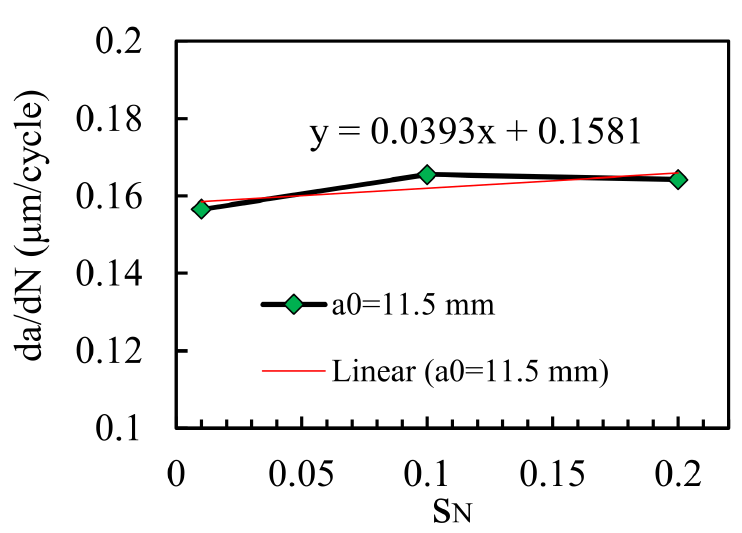
Figure 18. Effect of s N on da/dN . Results are presented in natural scales for three distinct values of s N : 0.01, 0.1, and 0.2. Coalescence is disabled , q 1 = 1.5, q 2 = 1, q 3 = 2.25, f 0 = 0.01, f N = 0.01, and ε N = 0.25.